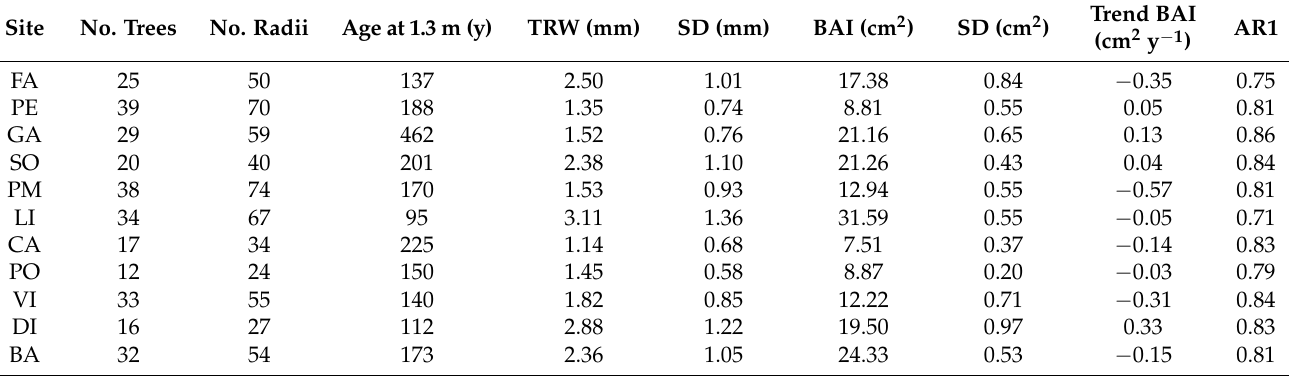
Table 2. Tree ring width data of the sampled silver fir sites. Abbreviations: AR1, first-order autocorre- lation; BAI, basal area increment; SD, standard deviation, TRW, tree ring width.